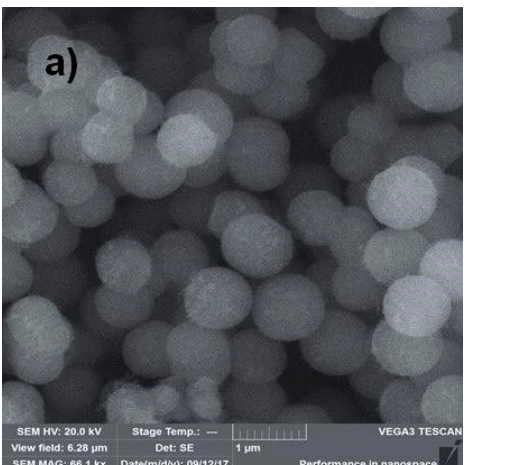
Figure 4. SEM images of ( a ) SiO 2 -C 3 H 6 -(30%)NH 2 and ( b ) 5 wt.% Pd/SiO 2 -C 3 H 6 -(30%)NH 2.